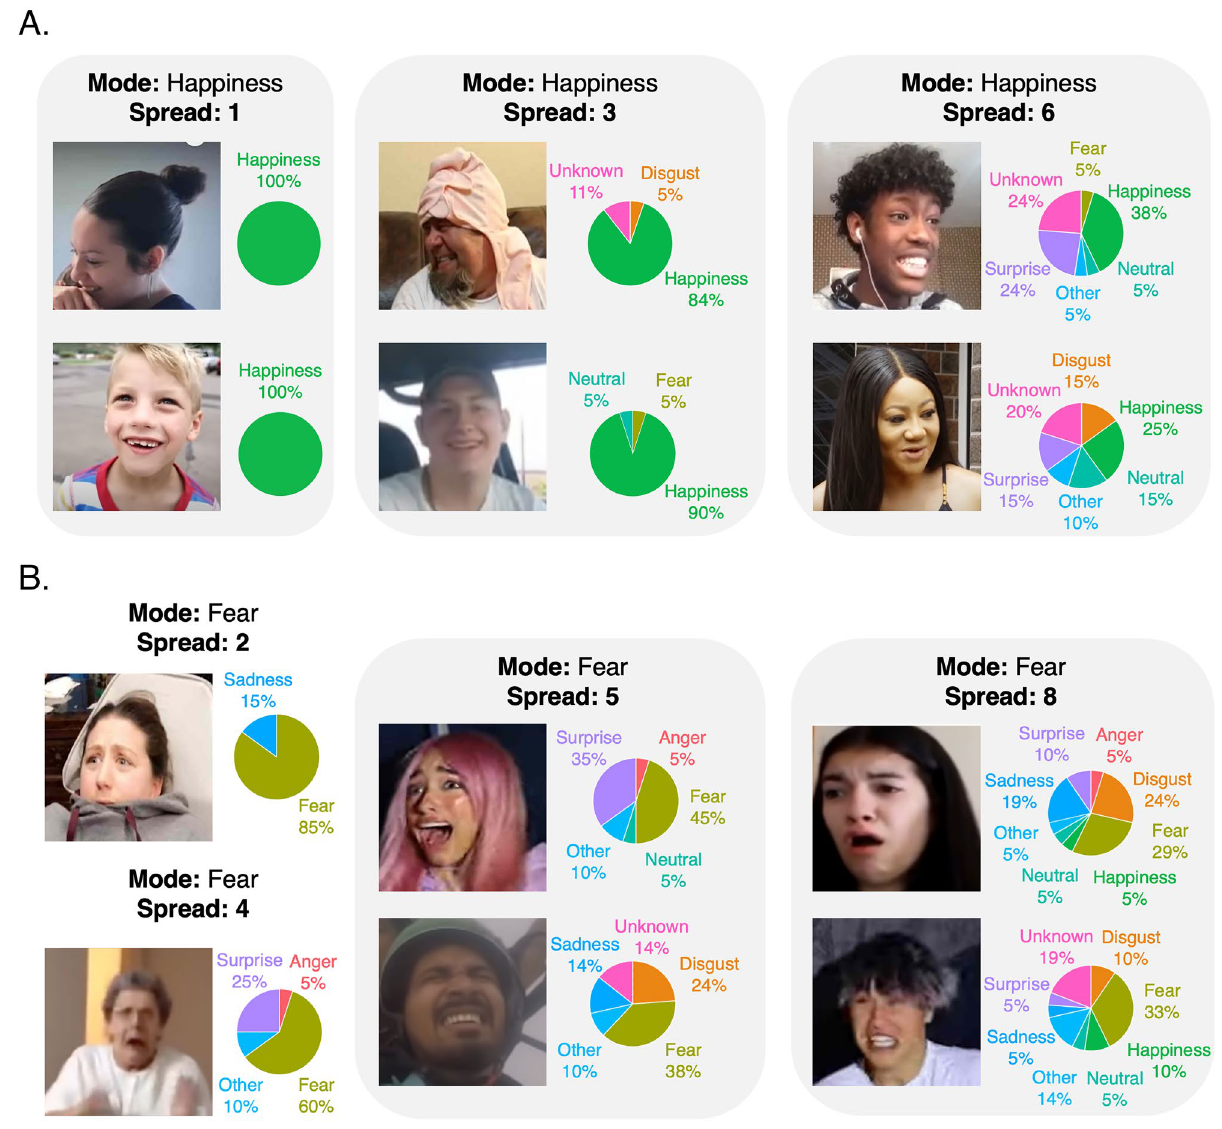
Figure 4. Six representative examples of WFD faces with modal scores of happy ( A ) and fearful ( B ). From left to right the examples vary in their categorical spread from low to high. Each image was categorized by 18–22 participants. The pie charts show the distribution of categorical responses for each